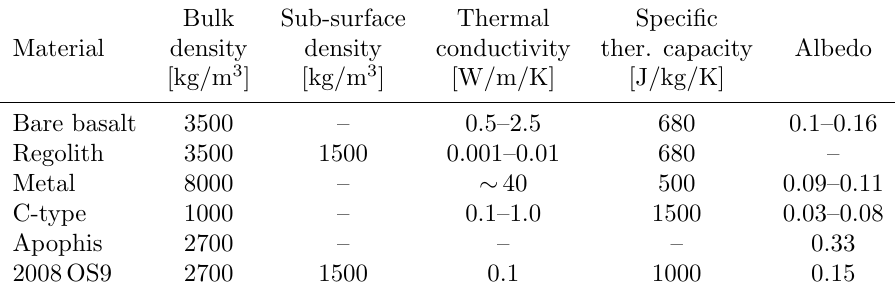
Table 5. Typical values of the material thermal parameters for modeling the Yarkovsky and YORP effects used by Broz (2003) and Giorgini et al. (2008) for Apophis and assumed in this work for clones of 2008